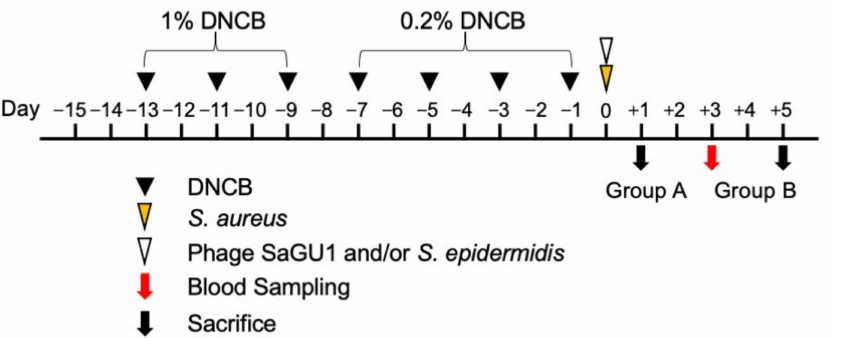
Figure 4. Schematic representation of the animal test for our phage therapy for atopic dermatitis (AD). Black arrowheads show the time at which 100 µ L of 1% DNCB and 0.2% DNCB were applied to the back skin for sensitization. Yellow and white arrowheads show 10 5 CFU of S. aureus SA-1 painting and 10 7 CFU of S. epidermidis SE-4 and 10 8 PFU SaGU1 (MOI = 1000) administration, respectively. The red arrow shows the time of blood sampling. Black arrows show time of sacrifice. Group A was used to excise the skin fragments for bacterial sampling. Group B was used to prepare the skin sections and obtain blood